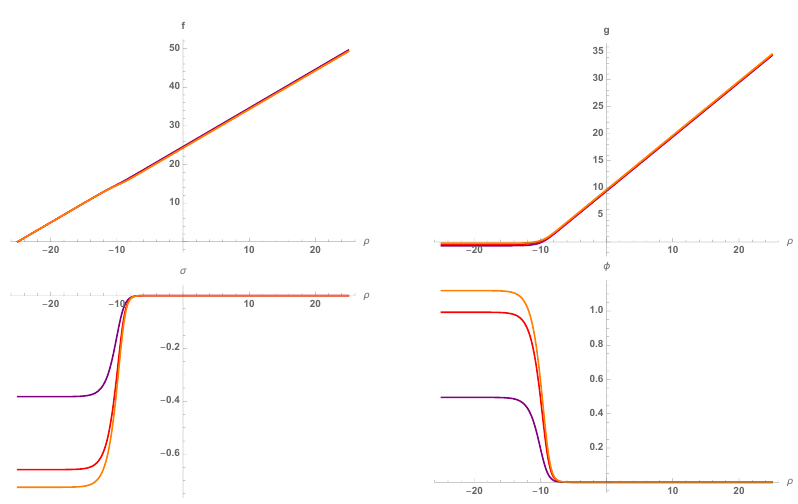
Figure 3 . Numerical black hole solutions with m = 1 = 2 and g = 3 m . We have b = (cid:0) 0 : 1 for purple, b = (cid:0) 0 : 3 for red, and b = (cid:0) 0 : 5 for